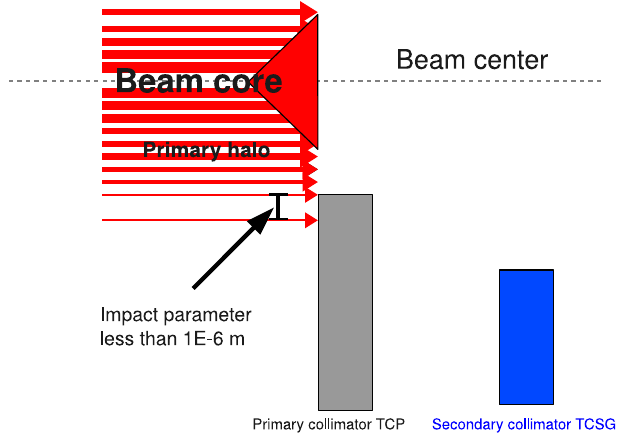
FIG. 23. (Color) Schematic of the impact parameter on the LHC primary